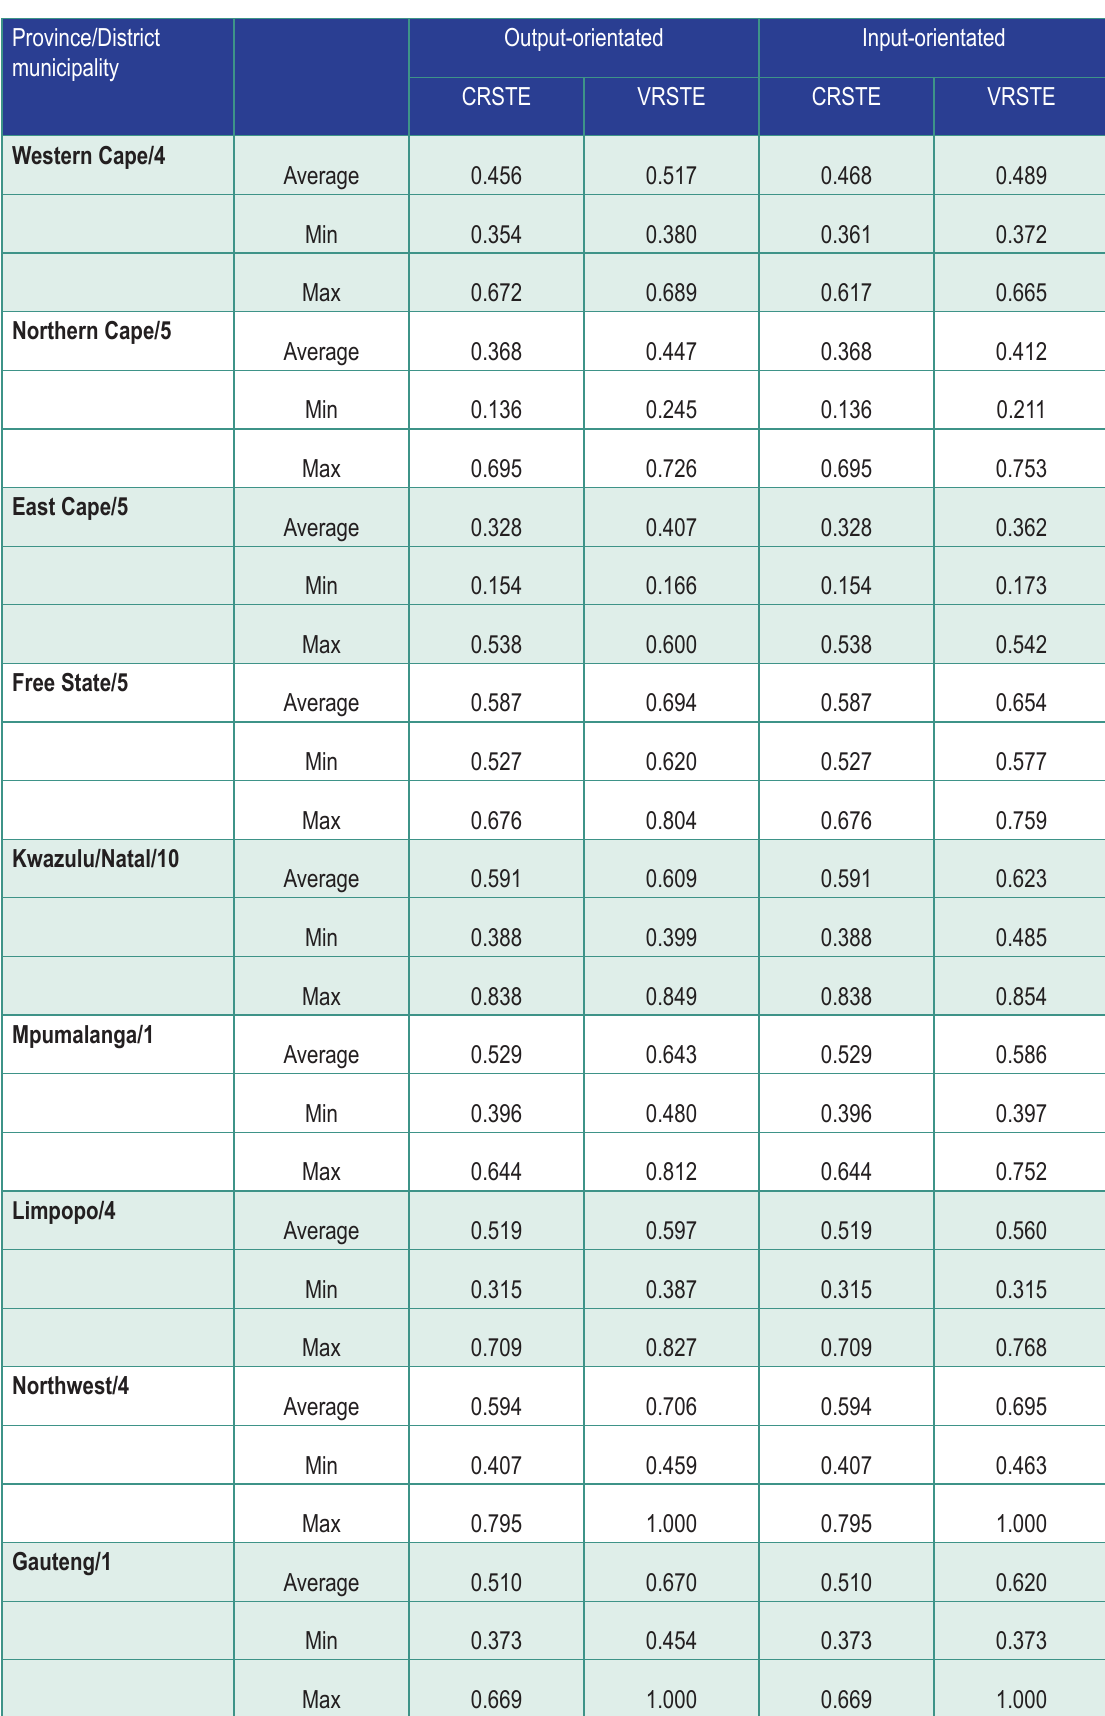
Table 3: Worst-Performing District Municipality per Province